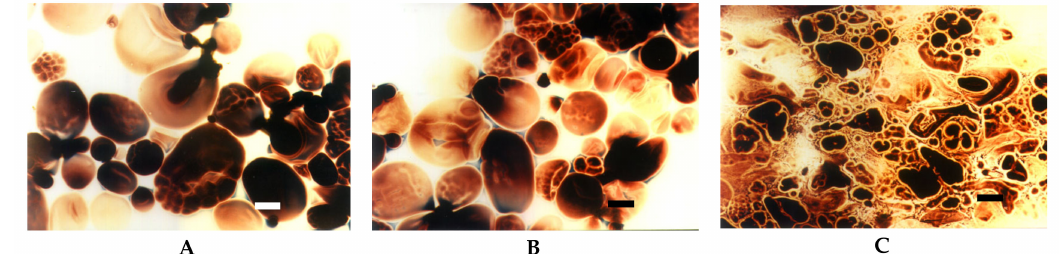
Figure 7. LM micrographs (20x) of acetylated starch of potato origin with di ff erent degrees of substitution incubated at the temperature of 60 ◦ C: ( A ) DS = 0.008, ( B ) DS = 0.018, ( C ) DS = 0.123 (Bar-20 µ